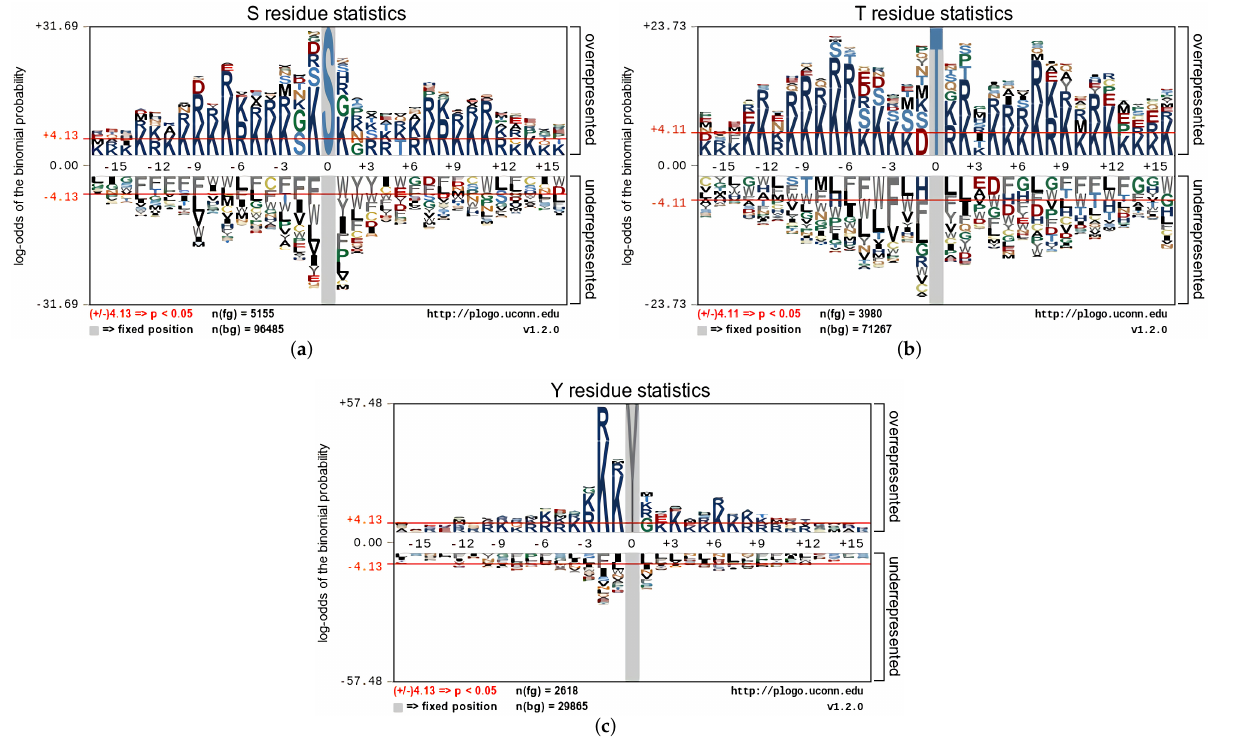
Figure 1. Sequence logo representation of phosphorylation. ( a ) Serine phosphorylation, ( b ) Threonine phosphorylation, ( c ) Tyrosine phosphorylation. The 16 residues upstream and downstream of the phosphorylation site are used to plot the sequence